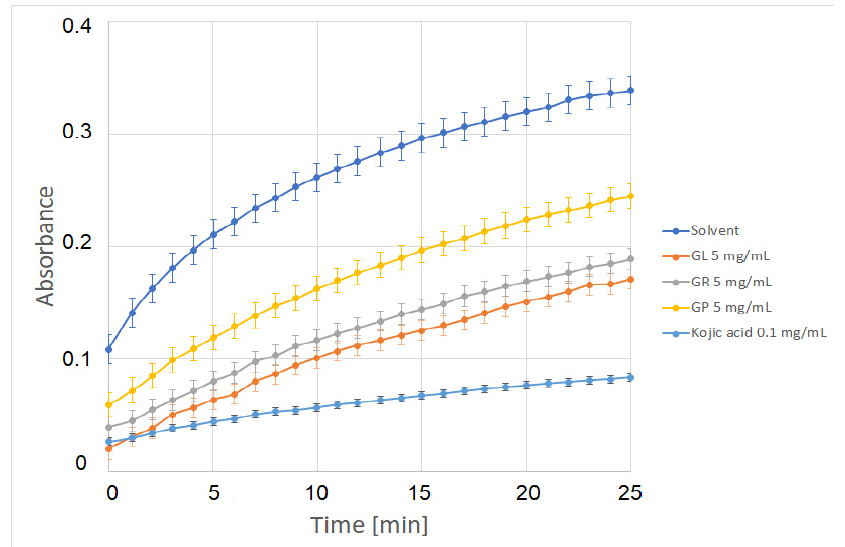
Figure 1. Changes in absorbance at 475 nm following 25 min incubation of buffer with tyrosinase and 0.5 mM L–DOPA with or without the tested extracts of G. lucidum (GL), G. resinaceum (GR), and G. pfeifferi (GP) at the concentration of 5 mg/mL as well as 0.1 mg/mL kojic acid. All the extracts were weaker inhibitors when compared with kojic acid at the concen- tration of 0.01 mg/mL (Table 4). Table 4. Tyrosinase inhibition properties of the tested extracts at the concentration of 5 mg/mL or kojic acid at the concentration of 0.1 mg/mL with 0.5 mM L–DOPA.